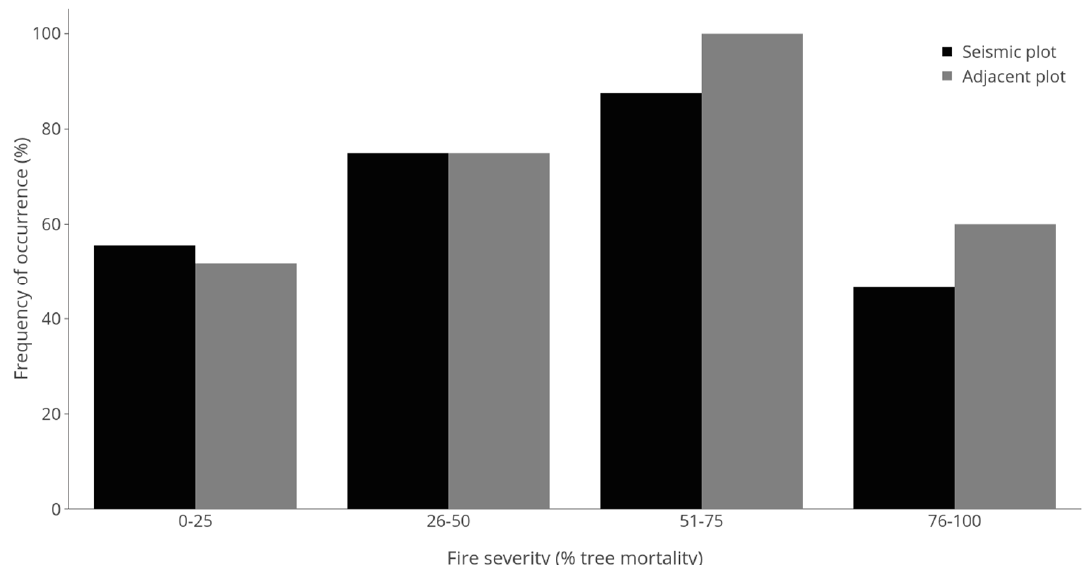
Figure 2. Frequency (presence) of Vaccinium myrtilloides plants in 30-m 2 plots on seismic lines versus adjacent forests across four fire severity classes. Comparisons between seismic and adjacent plots within individual fire severity classes using McNemar’s χ 2 tests revealed no significant ( p < 0.1) differences. Table 1. Mixed effect regression results relating the presence, abundance (cover), and vigor (maximum height) of Vaccinium myrtilloides plants as a function of location (seismic line versus adjacent forest), fire severity, and the interaction of fire severity (% tree mortality) and location. Model coefficients (Coef.), Standard Error (S.E.) of coefficients, and significance ( p ) reported. Main treatment variables were retained regardless of significance, while a non-linear effect for fire severity and interaction term between fire severity and seismic lines were included only if significant.